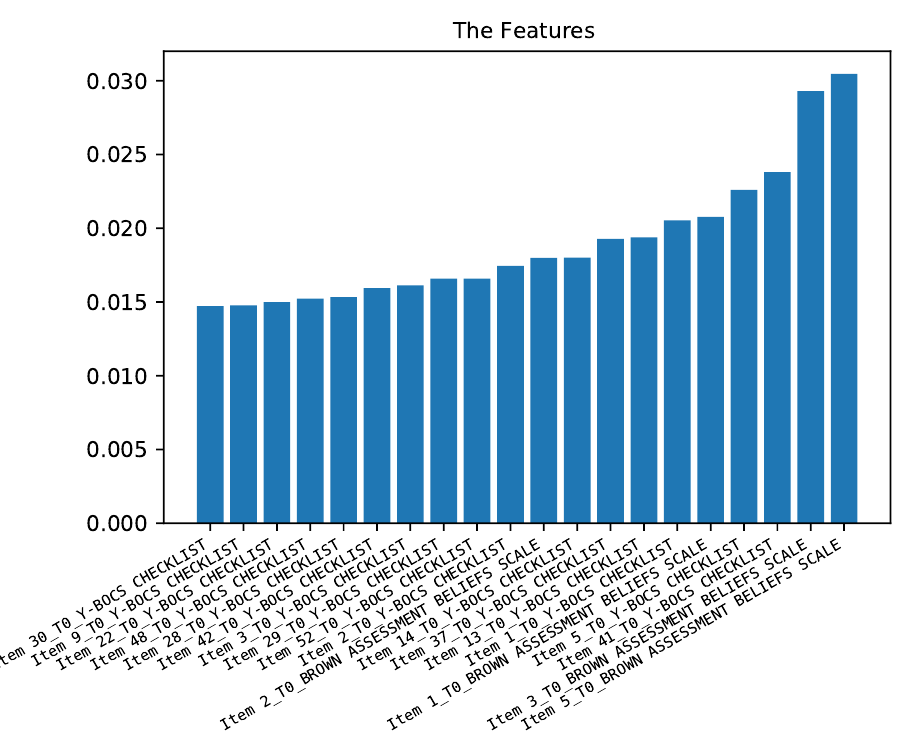
Figure 9. Importance of the different features for predicting belief symptoms.